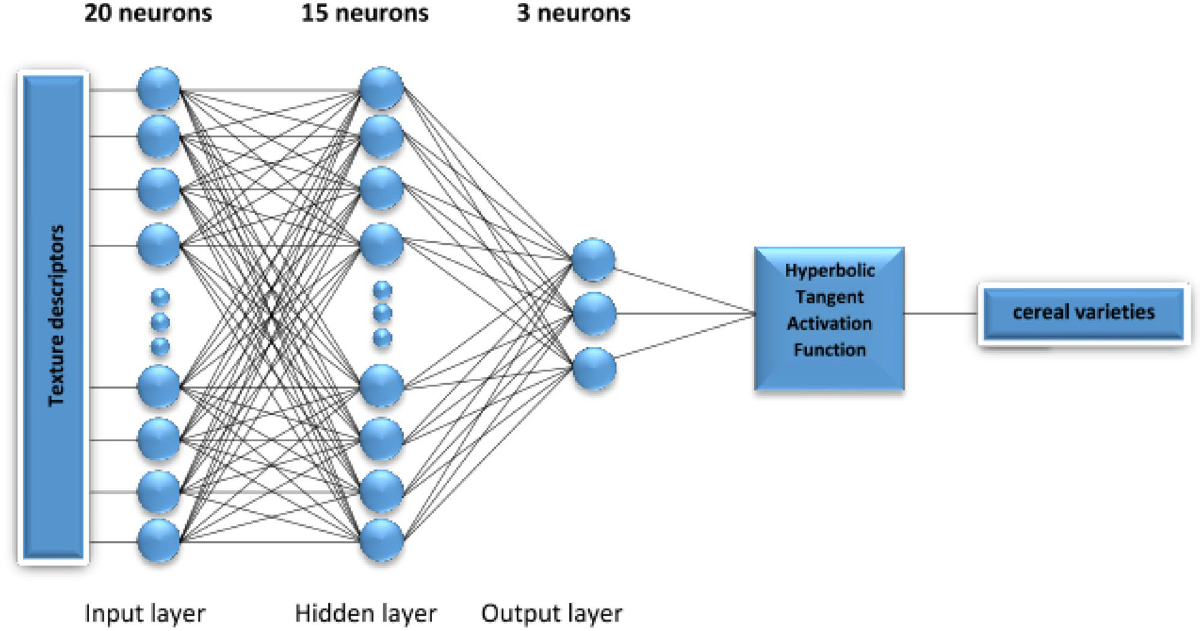
Figure 3. Artificial Neural Network used for the experimental